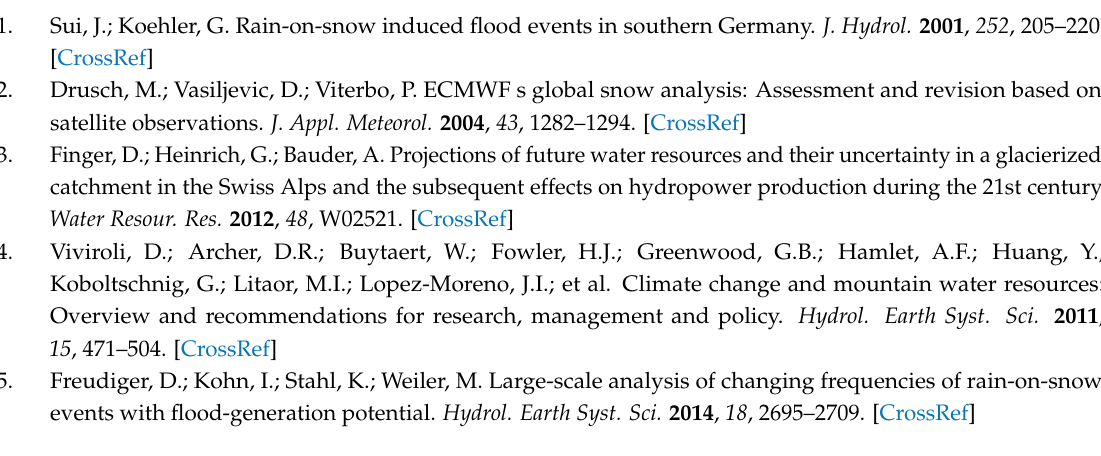
Supplementary Materials: COST ESSEM 1404 working group 3 survey: Questionnaire and results are available at